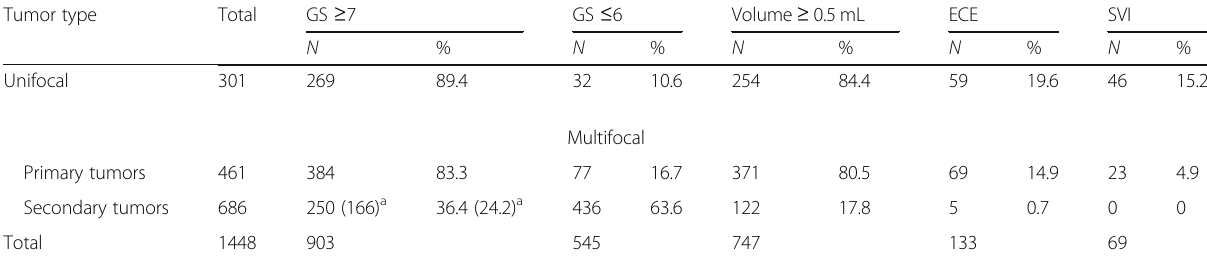
Table 2 Histological characteristics of individual tumor foci from 762 radical prostatectomy specimens Tumor